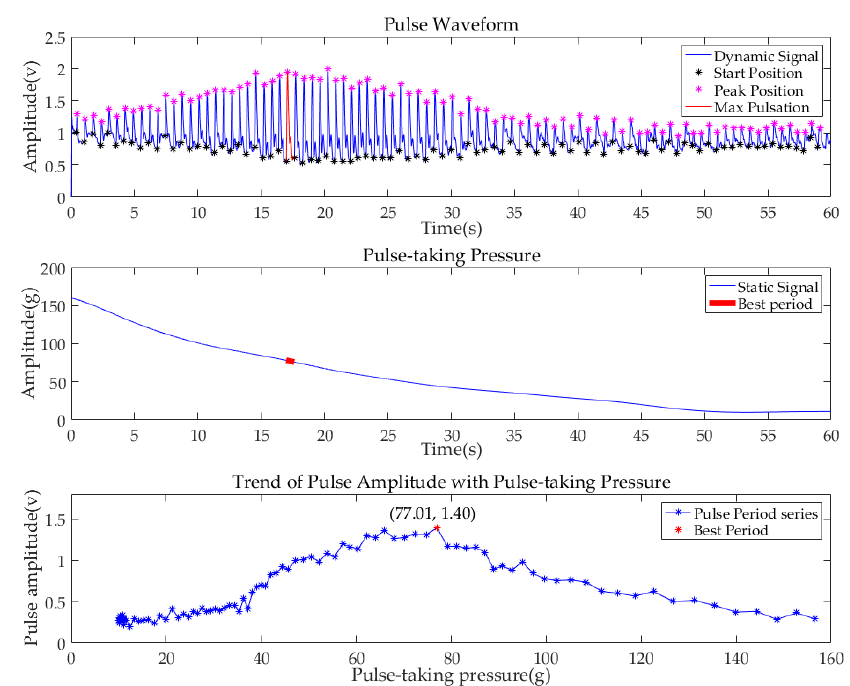
Figure 11. Pulse diagrams of subject (No.6) at the Guan region.